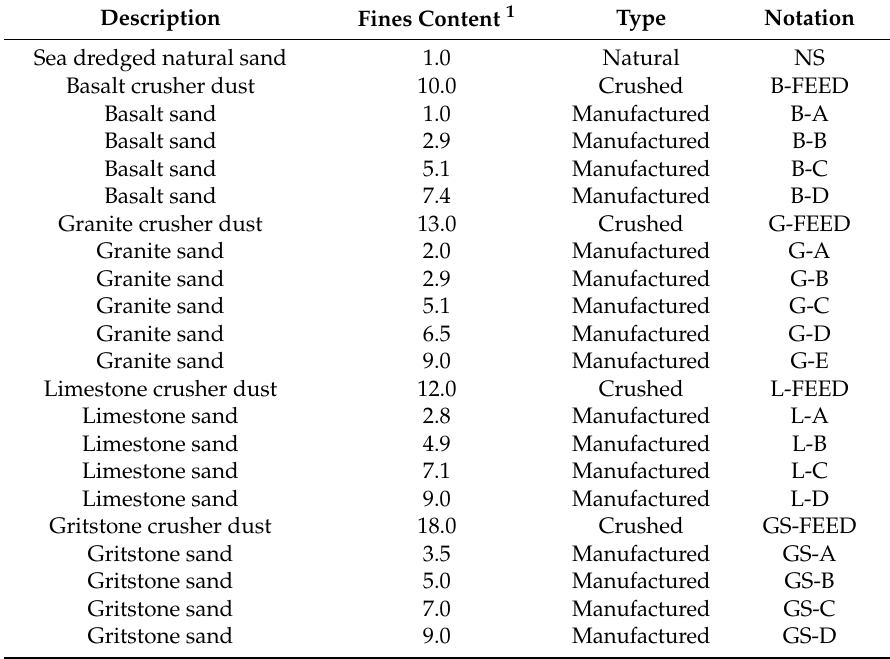
Table 2. Fine aggregate